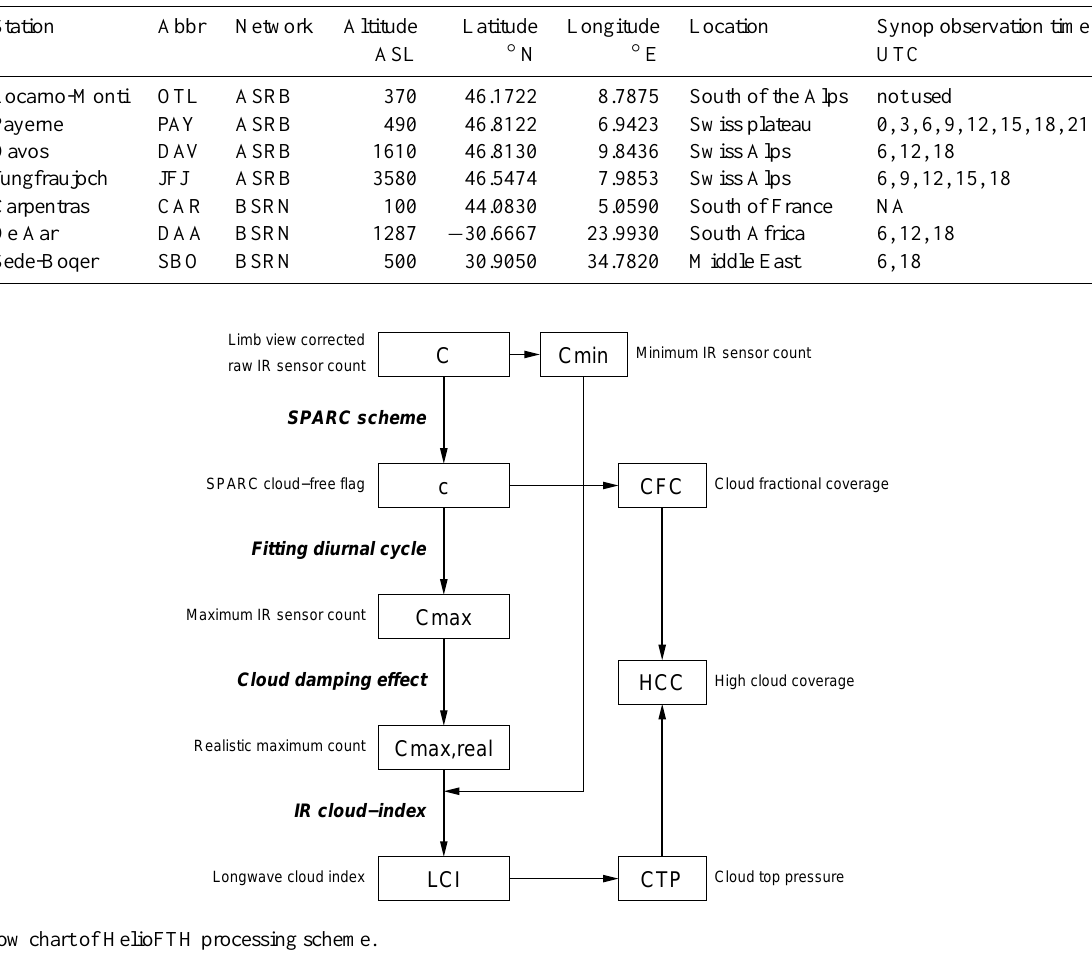
count, while C max , the maximum satellite’s raw IR sensor count, corresponds to a cloud free, clean and dry sky, and C min corresponds to the coldest cloud-top temperatures. Stand-alone cloud coverage products, i.e., cloud fractional coverage (CFC) and high cloud coverage (HCC), and an in- ternal cloud-top pressure (CTP) product for the separation of middle- and high-level clouds are obtained from limb- view corrected MVIRI raw IR10.8 sensor counts by use of LCI based on the Heliosat cloud index principles and with a cloud-free flag c based on a modified formulation of the SPARC scheme. Figure 1 shows the flow chart of the main processing steps of the HelioFTH scheme, which are de- scribed in detail in the following sections. The core element of the HelioFTH scheme is the cloud-free flag c , which sep- arates cloud free from cloudy